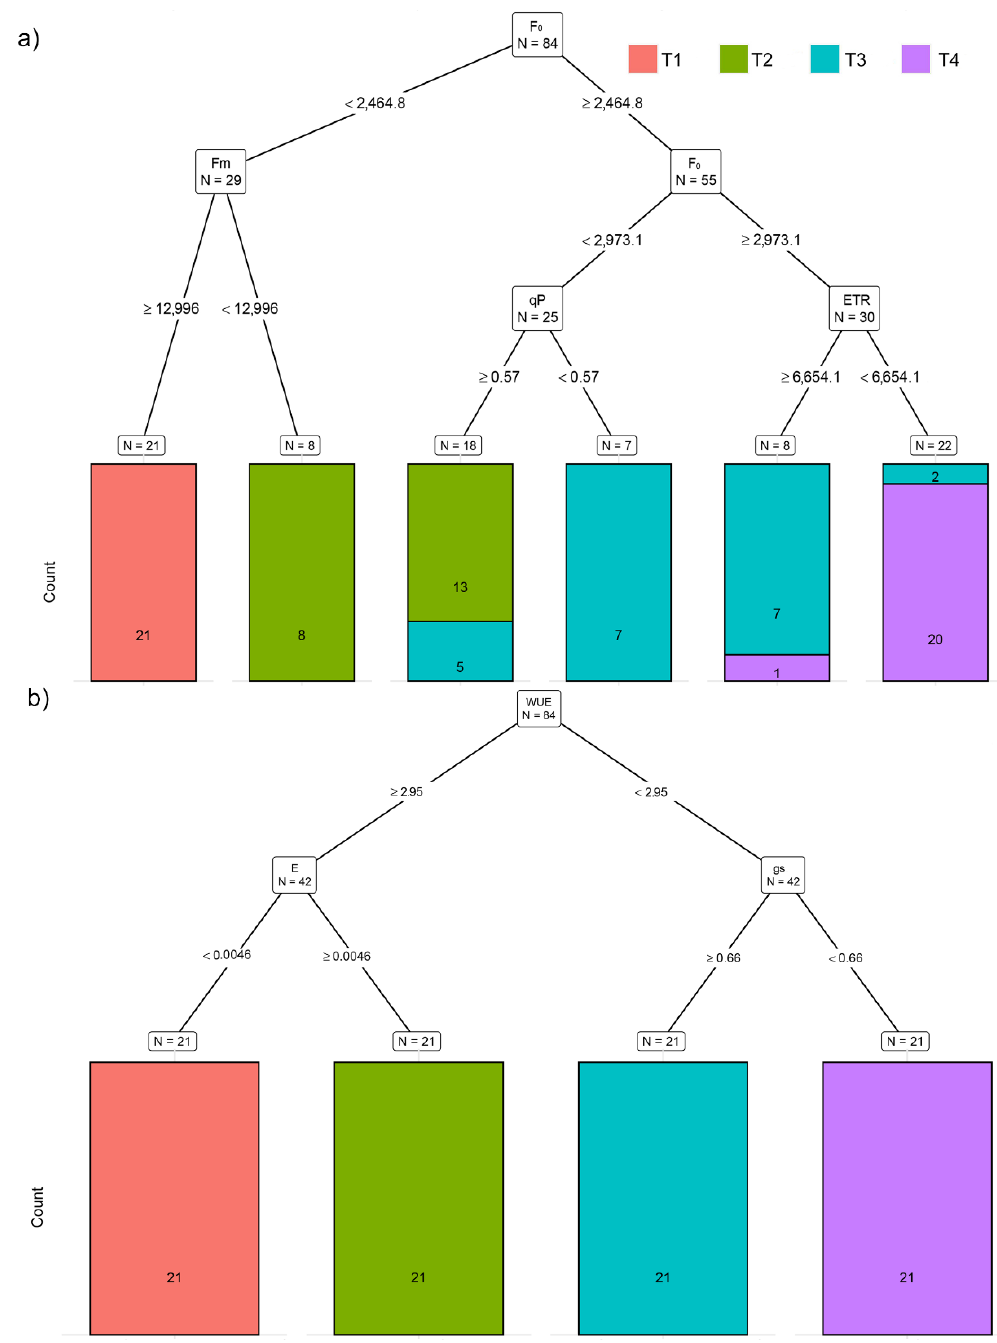
Figure 5. Visualization of classification tree for: ( a ) chlorophyll fluorescence traits (CFT) and ( b ) gas exchange traits (GEXT). Each node shows the predicted class (Treatment). Below each node are counts of observations classified into each class (in the following order: T1, T2, T3, and T4) and the percentage of observations in the node. Each split shows the selected variable and cutoff value for each step in the classification tree. Legend: T1 (20/15 °C), T2 (25/20 °C) T3 (30/25 °C), and T4 (35/30 °C).